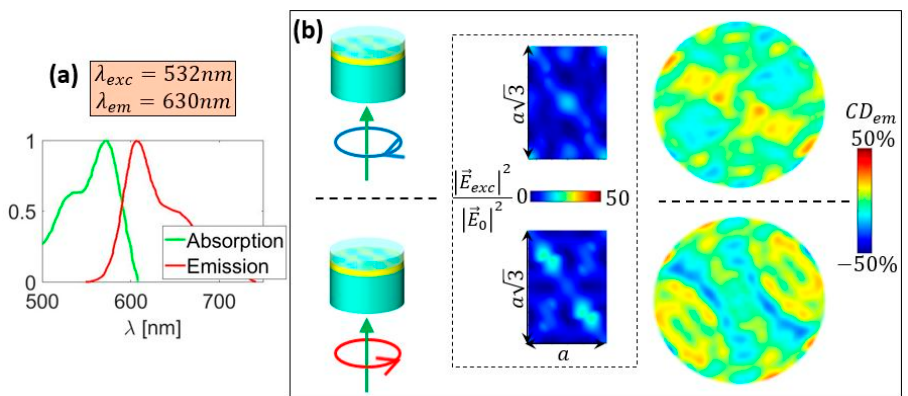
Figure 10. ( a ) Typical absorption and emission spectra for Lumogen Red dye [45]. ( b ) CD em for RCP (top) and LCP (bottom) excitations of Ag-ENHA excited at λ exc = 532 nm, and emitting at λ em = 630 nm; the inset shows the xy cross-sections of the electric field intensity, as in Figure